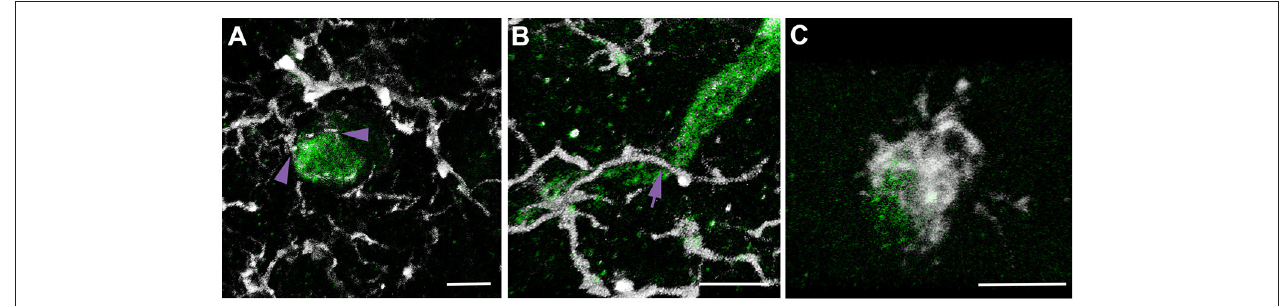
FIGURE 2 | Multiple types of microglial process contacts onto axonal segments were observed following brain injury. Representative 3D reconstructions of APP + injured axonal swellings (green) and Iba-1 + microglia (white). (A) Microglial processes that terminated on the axonal surface were considered “terminal processes” (purple arrow heads). (B) Processes that continued past the axon were considered “process passes” (purple arrow). (C) Processes that encircled the axon were considered “process cups.” This nomenclature and identification scheme was used for all assessments of microglial physical interactions with axons in rats and micro pigs throughout the